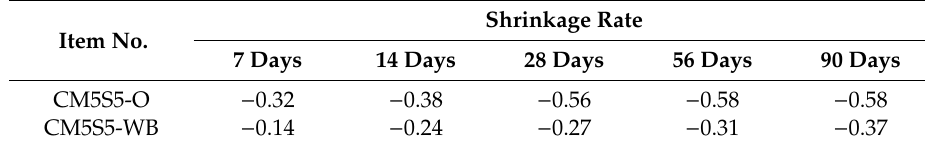
Table 8. Shrinkage rate of marble-based geopolymer concrete synthesized with recycled aggregate. Item No.